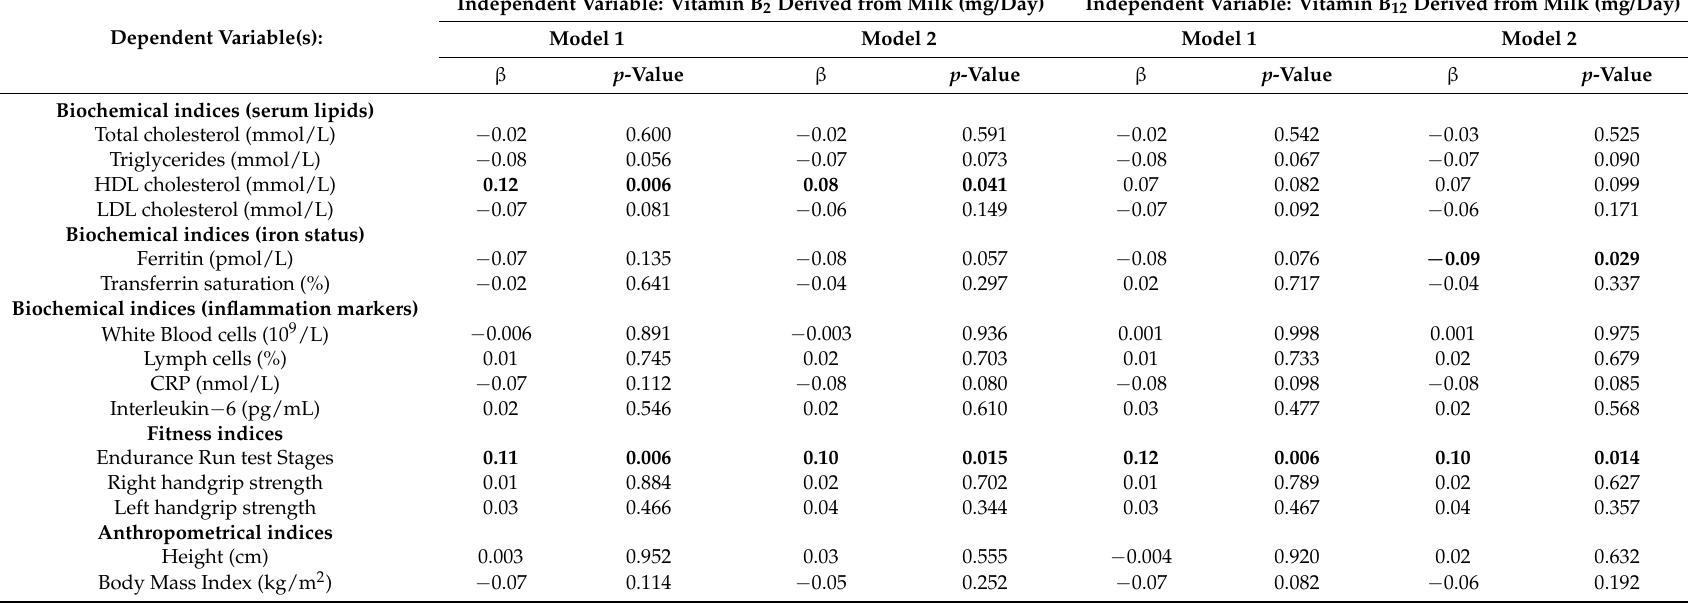
Table 3. Regression models testing the associations of vitamin B 2 and vitamin B 12 derived from milk with biochemical, fitness and anthropometrical indices of health status after controlling for potential relevant confounders and possible effect